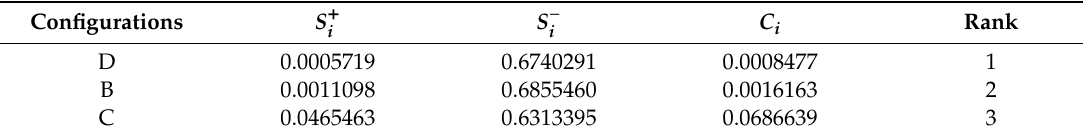
Table 6. Relative closeness to ideal solution, intuitively weighting